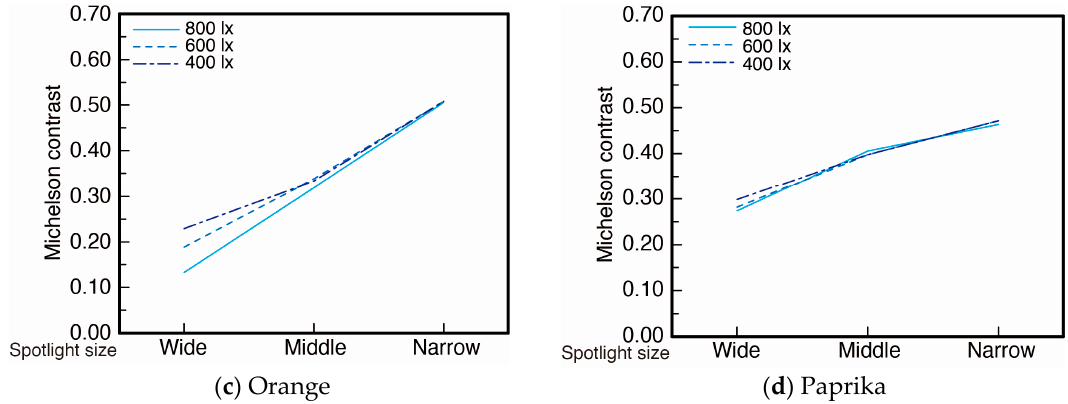
Figure 4. Relation between the Michelson contrast of luminance on samples and spotlight size under three illuminance levels for ( a ) Apple, ( b ) Eryngii, ( c ) Orange, ( d ) Paprika.